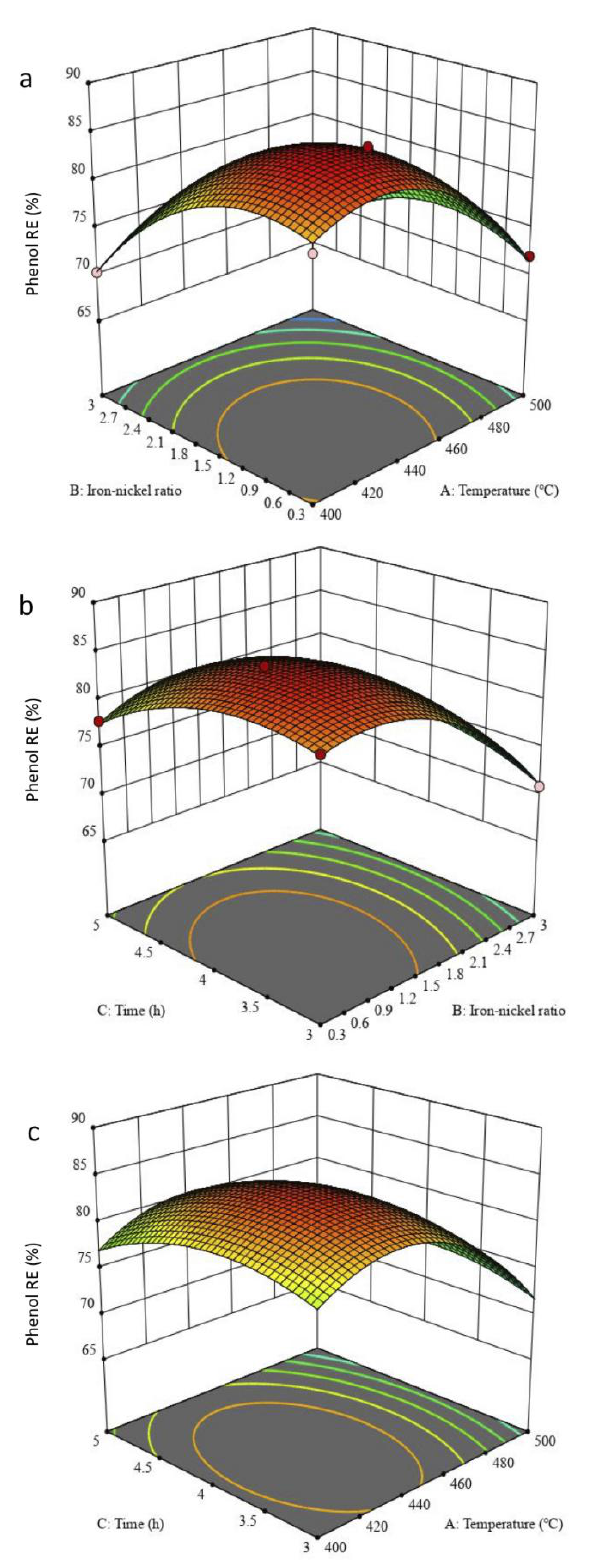
Figure 1. Response surface of phenol removal efficiency (RE) as a function of temperature and iron-nickel ratio ( a ), iron-nickel ratio and time ( b ) and temperature and time ( c ).